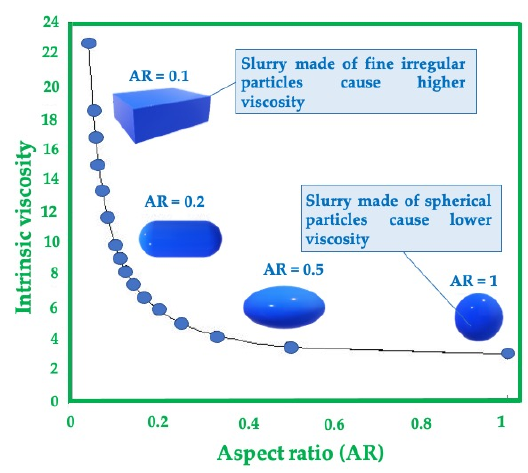
Figure 22. Variation of the aspect ratio of particles by intrinsic viscosity of the solution (modified from [240]). from